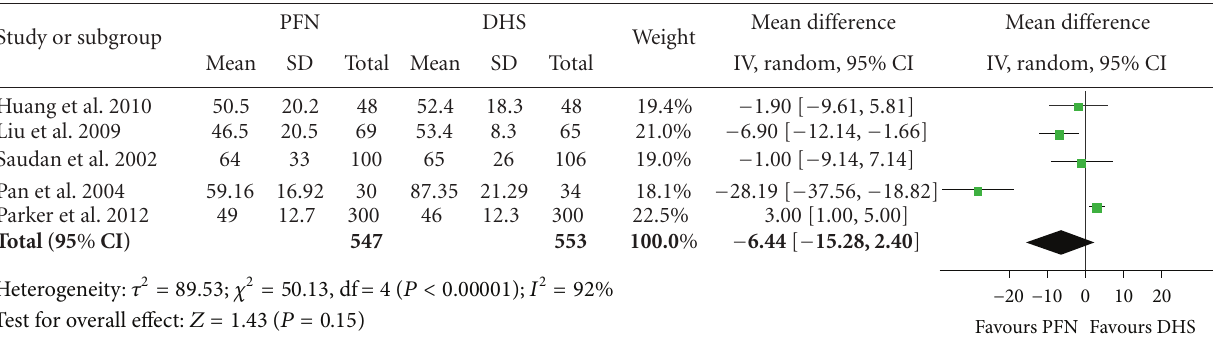
Figure 2: Comparison of operation time between PFN and DHS.